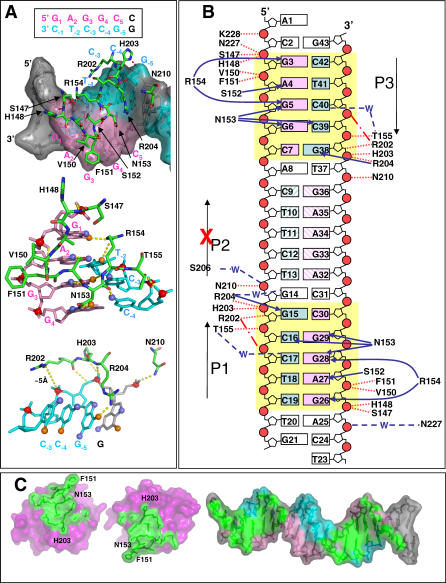
T-ag obd–DNA Interactions(A) Three close-up views of the protein–DNA interaction observed in the T-ag obd–DNA co-structure. In this figure, the GAGGC duplex is numbered and colored as shown in the boxed sequence. The top view shows both the A1 and B2 loops in the major groove of the DNA. The A1 and B2 loops are shown as sticks colored by atom type (carbon green, nitrogen blue, oxygen red). The DNA is shown as sticks with a translucent molecular surface and is colored as in Figure 2A. Red dashed lines indicate hydrogen bonds or electrostatic interactions. Residues are labeled. The middle and bottom views show the protein–DNA contacts from the A1 loop and the B2 loop, respectively. Atoms from the DNA involved in hydrogen bonds (yellow dashed lines) are shown as spheres: phosphate (red), oxygen (orange), and nitrogen (blue).(B) Schematic representation of protein–DNA interactions in the crystal structure. The DNA is numbered as shown. The GAGGC sequences of P1 and P3 are colored pink and their complements are colored cyan. The mutated P2 sequence is shown with the same coloring but with hash-marks. The P1 and P3 pentamers are placed in a yellow box. Arrows indicate the 5′ → 3′ direction of the GAGGC sequence. The red dotted lines indicate contacts with the phosphate backbone, and the blue solid arrows indicate sequence-specific H-bonds or salt-bridges. Blue dashed lines indicate observed water (W) mediated hydrogen bonds. (The dash-dot-dash line from Arg 202 indicates a phosphate interaction that could easily occur between the guanidinium group and a phosphate but is not observed in the structure.)(C) T-ag obd–DNA interface. The T-ag obd and DNA molecules are separated to show the interaction surface. Residues of T-ag obd which interact with DNA (and vice versa) are shown in green, and the rest of the T-ag obd molecule is magenta. The DNA is colored as in Figure 2A, but the surfaces which interact with T-ag obd are colored green. This exploded view clearly shows the two buried interaction surfaces (one for each T-ag obd) fill the major groove of the pentameric binding sites and that they occur on the same face of the DNA.